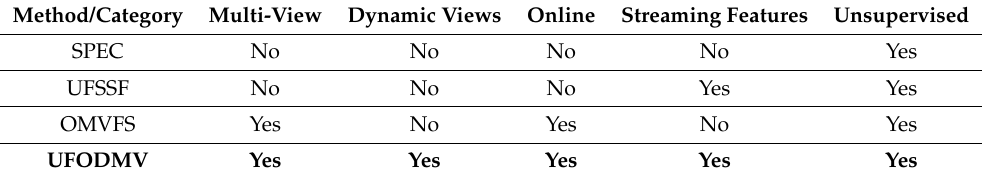
Table 2. Summary of the proposed and benchmarked